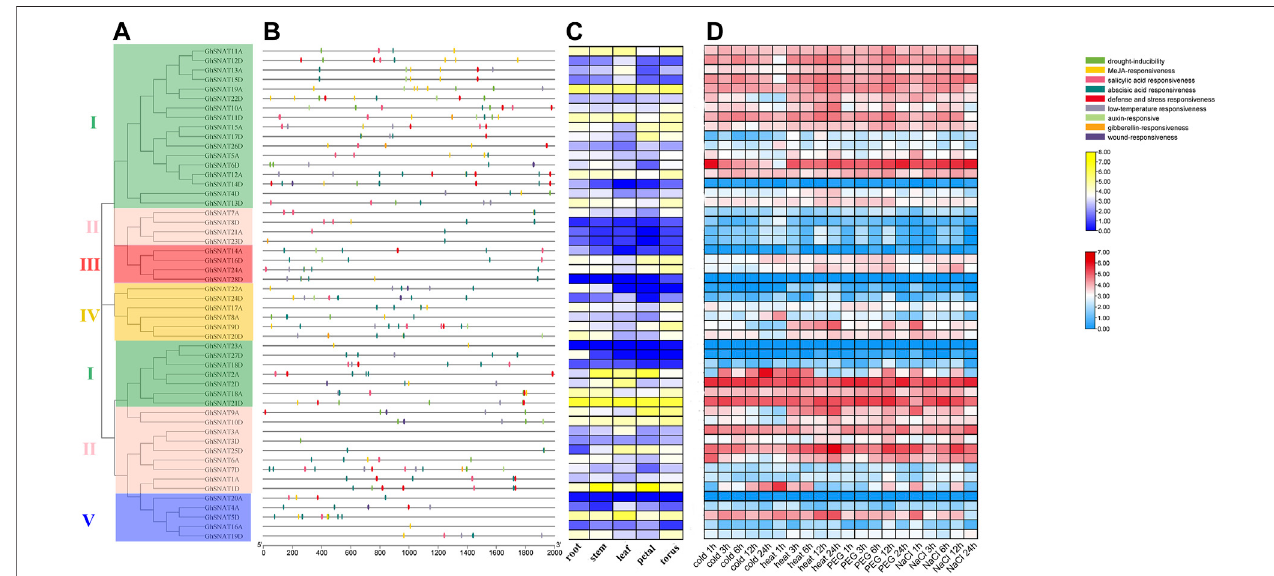
FIGURE 4| Expression pattern and promoter analysis of the SNAT gene family in Gossypium hirsutum . (A) : The phylogenetic tree of GhSNAT s; (B) : The promoter analysis of GhSNAT s; (C) : The organizational expression of GhSNAT s; (D) : The expression patterns of GhSNAT s under abiotic